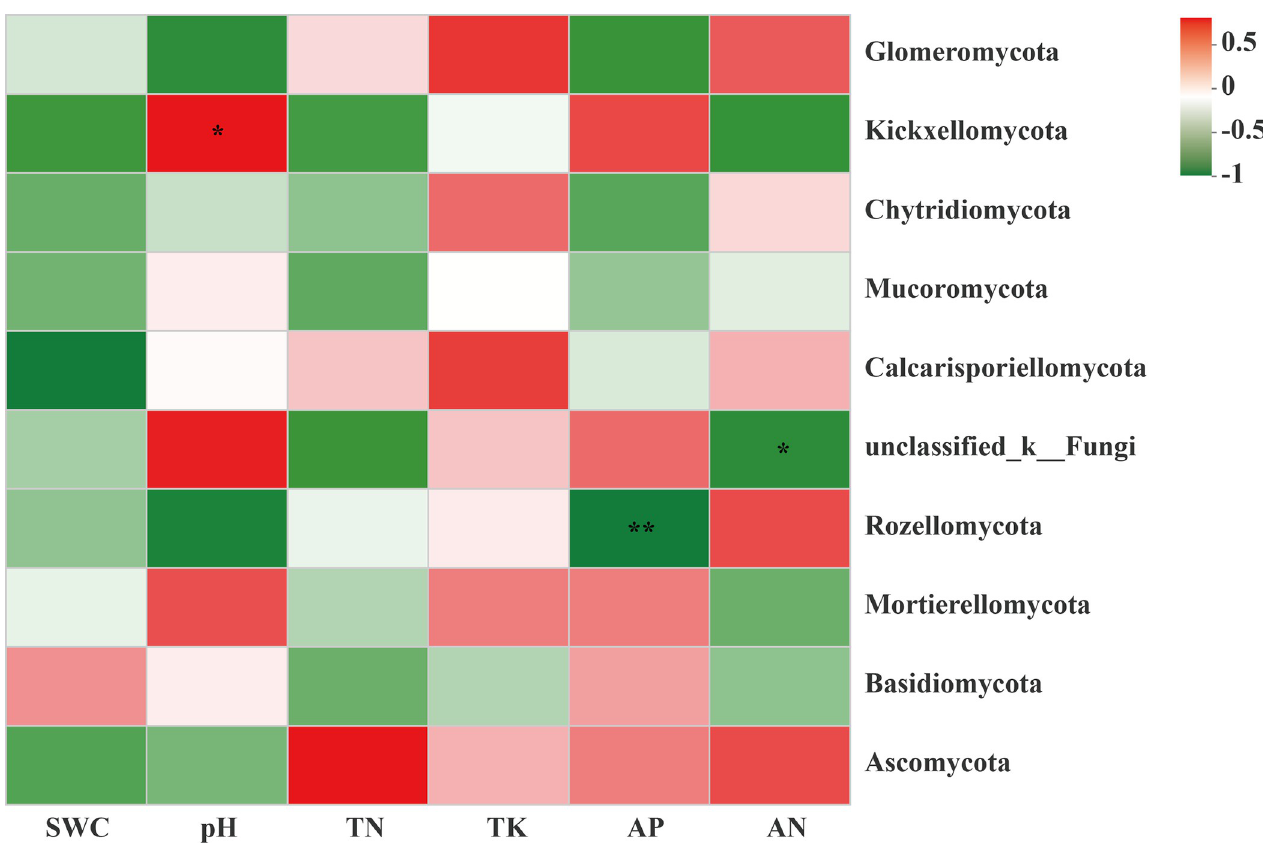
Fig 10. Correlation heatmap analysis between edaphic physicochemical factors and bacterial population at phylum level between moss- (M) and non- moss growth (L) areas in litchi orchard. Note : R values are shown in the figure in different shades of color, and they are marked with � , �� , or ��� , indicating p values less than 0.05, 0.01, and 0.001,